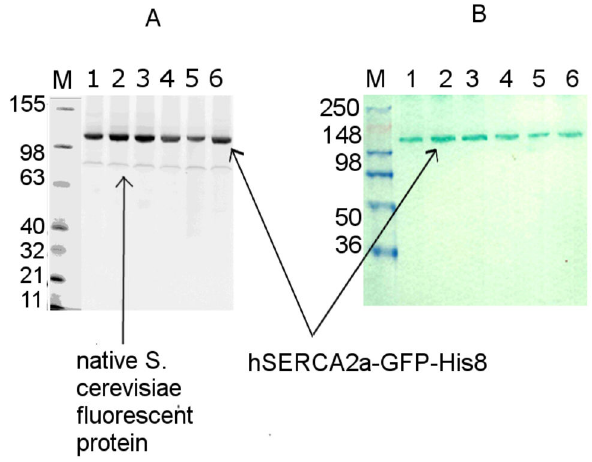
Figure 1. Small scale expression test for h SERCA2a-GFP- His using different 8